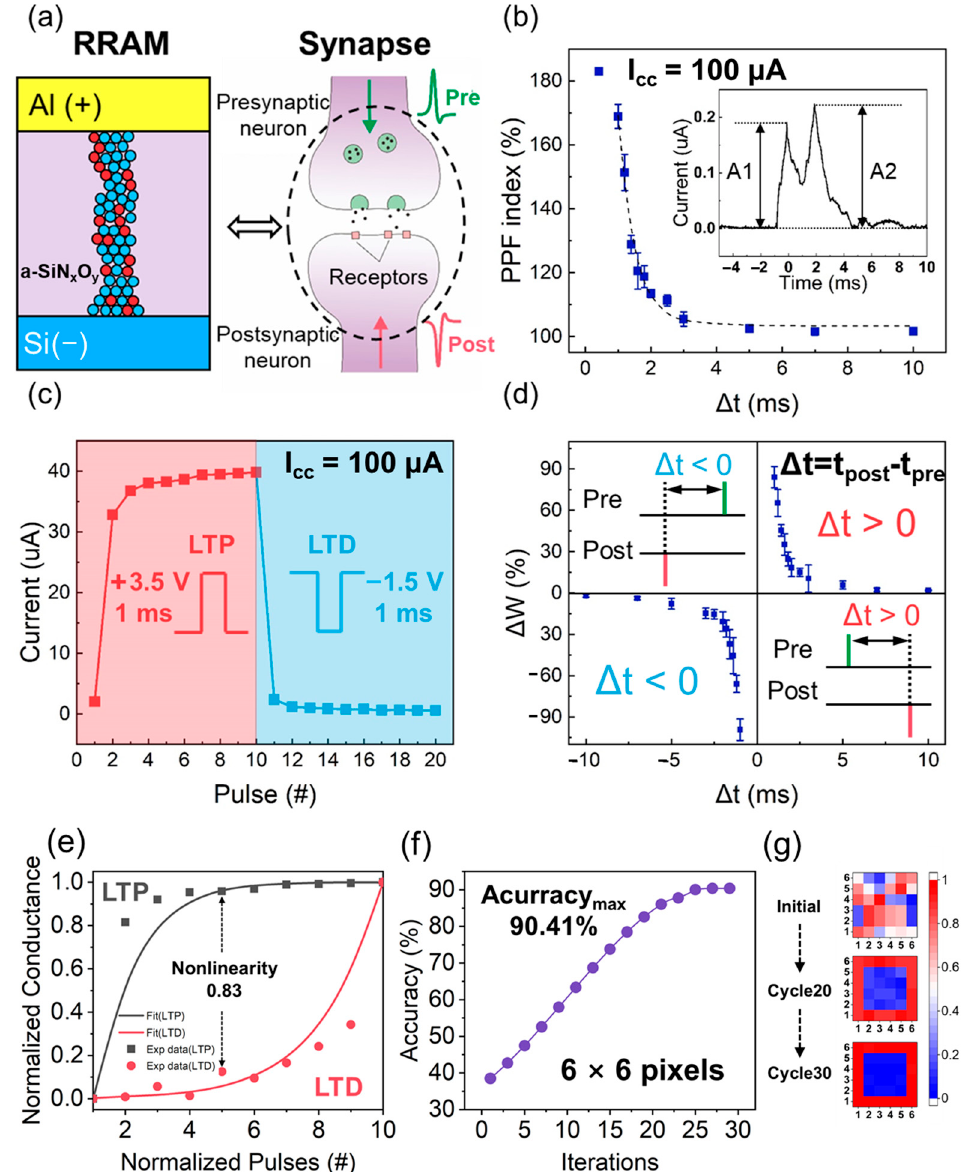
Figure 6. ( a ) Illustration of the structure similarity of Al/a-SiN x O y :H/P + -Si device to a biological synaptic junction between the pre- and postsynaptic neurons; ( b ) PPF characteristics of the electronic Al/a-SiN x O y :H/P + -Si synapse with I cc = 100 µ A; ( c ) LTP and LTD characteristic of Al/a- SiN x O y :H/P + -Si device with I cc = 100 µ A, 3.5 V/1 ms pulses is adopt for potentiating (red point) and − 1.5 V/1 ms pulses is applied for depression (blue point); ( d ) STDP characteristic of the elec- tronic Al/a-SiN x O y :H/P + -Si synapse with I cc = 100 µ A. ( e ) Normalized synaptic characteristics of a-SiN x O y :H memristor using the conventional BP-scheme (Bipolar-pulse Scheme). ( f ) The train- ing accuracy of the neural network consisting of 6 × 6 synapses based on a-SiN x O y :H memristor. ( g ) Various images corresponding to the 6 × 6 synapses after training for 20 and 30